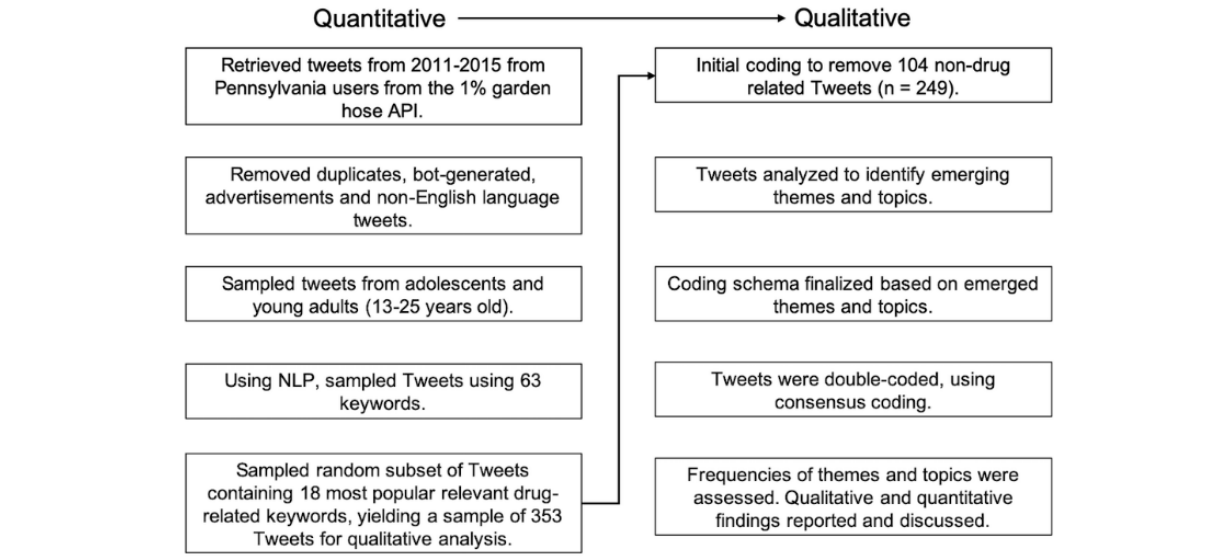
Figure 1. Data flow diagram. API: application programming interface; NLP: natural language